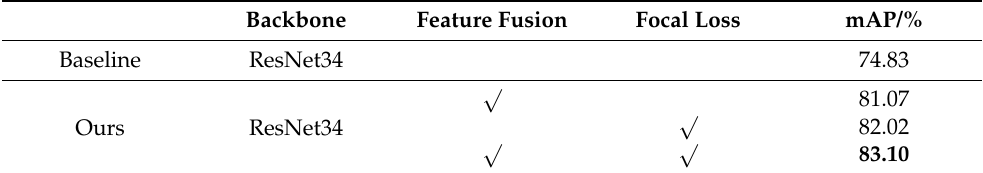
Table 6. Ablation results of each component based on SIXray10 subset. Backbone Feature